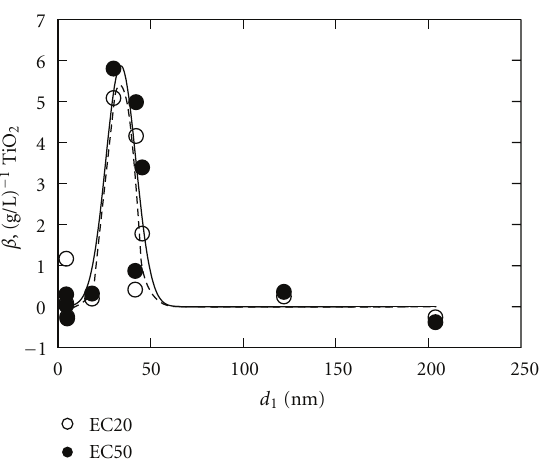
Figure 5: Critical specific chlorophyll a content ( β ) as a function of primary particle size of TiO 2 in terms of EC20 and EC50. Lines are fitted 3-parameter Gaussian equation (7) in SigmaPlot ver. 9.01 for EC20 (dotted) and EC50 (solid). Experimental conditions: initial algae concentration = 1 . 4 ± 0 . 9 × 10 6 cell/mL, test duration = 4 days, and initial test volume = 200 mL.